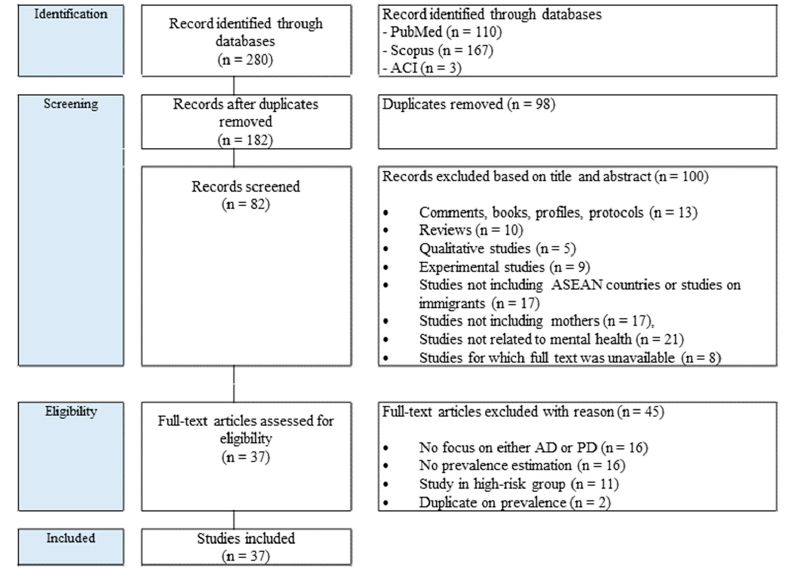
Figure 1. PRISMA Figure 1. PRISMA diagram.